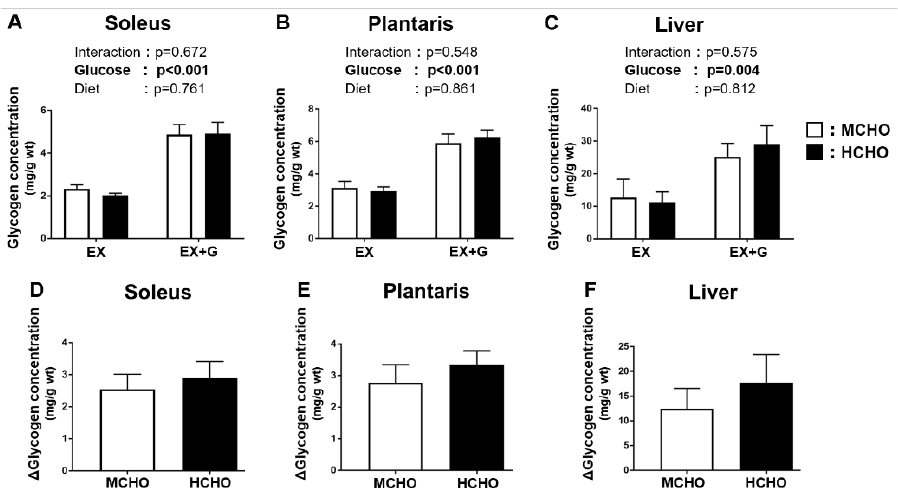
Figure 3. Glycogen concentrations in ( A ) soleus and ( B ) plantaris muscle and ( C ) liver of mice fed the HCHO (black) or MCHO (white) diet. Tissues were harvested immediately after treadmill running (EX) or 30 min after the post-exercise oral glucose administration (1.5 mg/g BW, EX + G). ( D – F ): Difference in glycogen concentration between the EX + G and EX mice in each diet group ( ∆ glycogen concentration). Values are mean ± SE (n = 6–8).